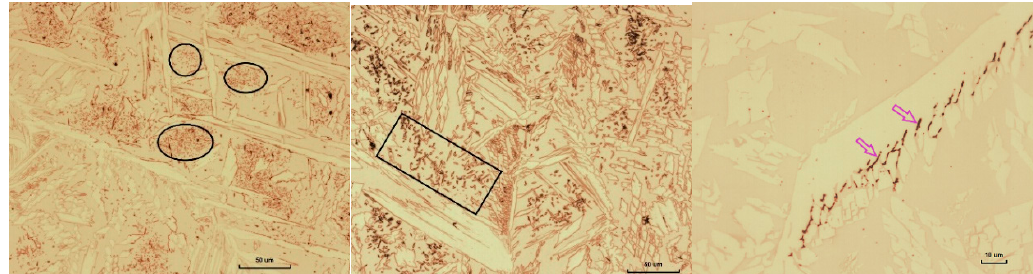
Figure 14. Micrographs from the GR welds showing the microstructure of Weld Pass 1 (GTAW Root). ( Left ) Massive amounts of nitrides in the ferrite grains in the as-deposited condition. ( Center ) Secondary austenite formation in the ferrite grains after reheated caused by Weld Pass 2. ( Right ) The σ -phase after six reheats.